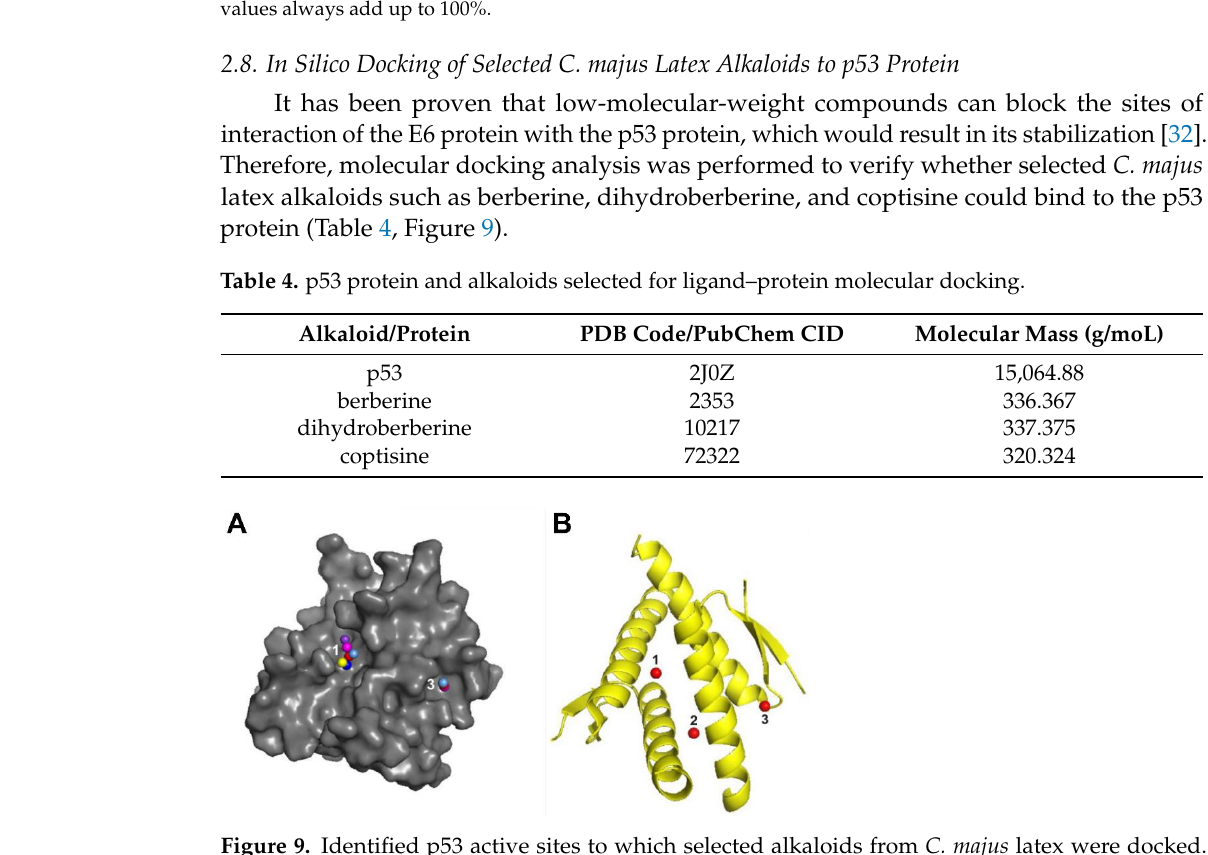
Figure 9. Identified p53 active sites to which selected alkaloids from C. majus latex were docked. ( A ) Colored dots represent the identified hot spots by different predictors. ( B ) p53 with all three active sites (1–3) to which berberine, dihydroberberine, and coptisine were docked. The illustrations were generated in PyMol